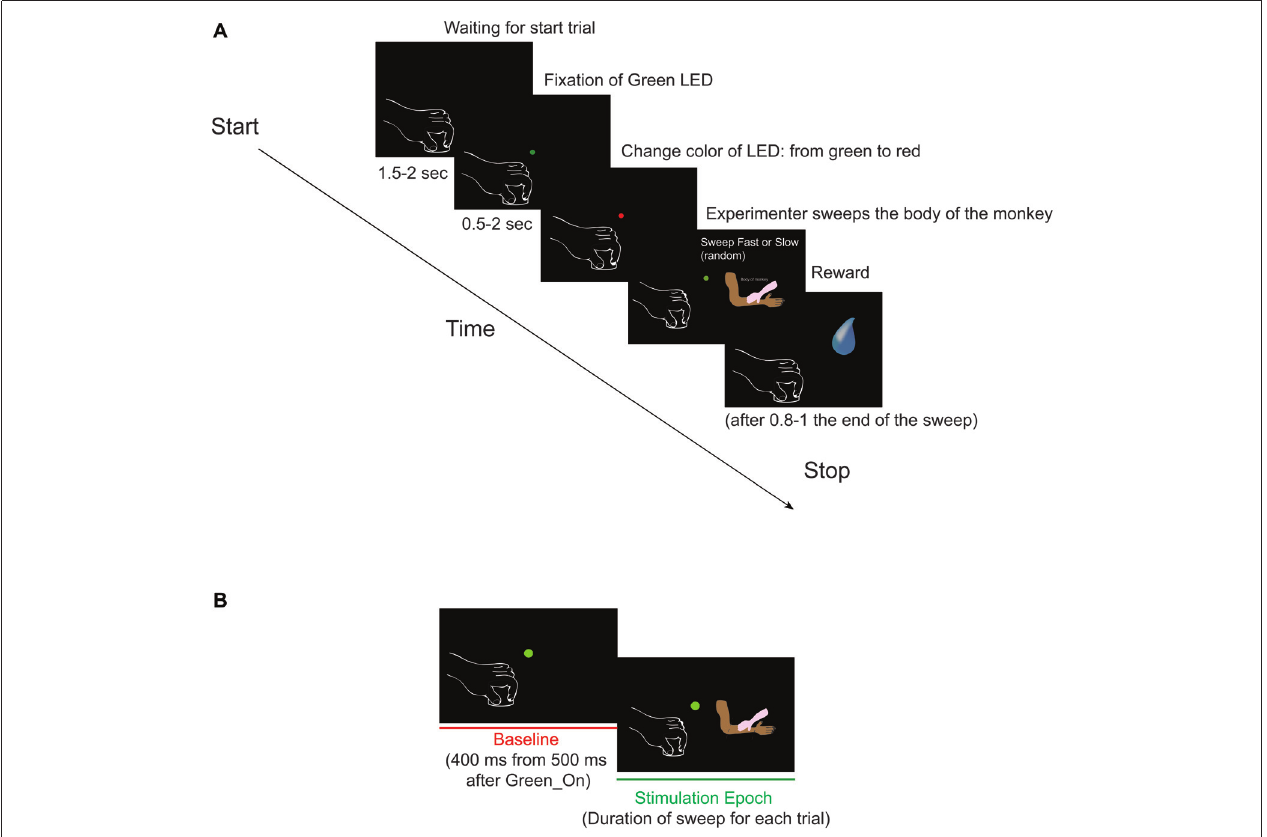
FIGURE 1 | (A) Somatosensory task: Sweep Slow and Sweep Fast. The two sweeping were randomly applied, but for both the task was the following: (1) Green_On—Green_Off: the green light-emitting diode (LED) turned on for 0.5–2 s. We requested monkey to fixate the LED for all duration. (2) Red_On: the green LED switched to red and the experimenter moved the hand toward the monkey’s body part to be stimulated. We requested monkey to maintain the fixation. (3) Trg2_On—Trg2_Off: the experimenter touched the monkey (Trg2_On). The red LED switched off and the green LED was turned on until the sensory stimulation was finished (Trg2_Off). We requested monkey to maintain the fixation until the end of the sweeping. (4) Once the sweep had finished, the green LED switched off and after 0.8–1 s the monkey received drops of juice as a reward. After 1.5–2 s, the next trial began. From the end of stimulation to the start of the next trial we did not request the monkey to carry out any fixation task, but just to maintain the hands in their position. (B) The two epochs employed for statistical analyses. (1) Baseline: from 500 to 900 ms after Green_On (total of 400 ms); and (2) Stimulation: from Trg2_On to Trg2_Off. (For details see “Recording of Behavioral Events and Definition of Epochs of Interest”